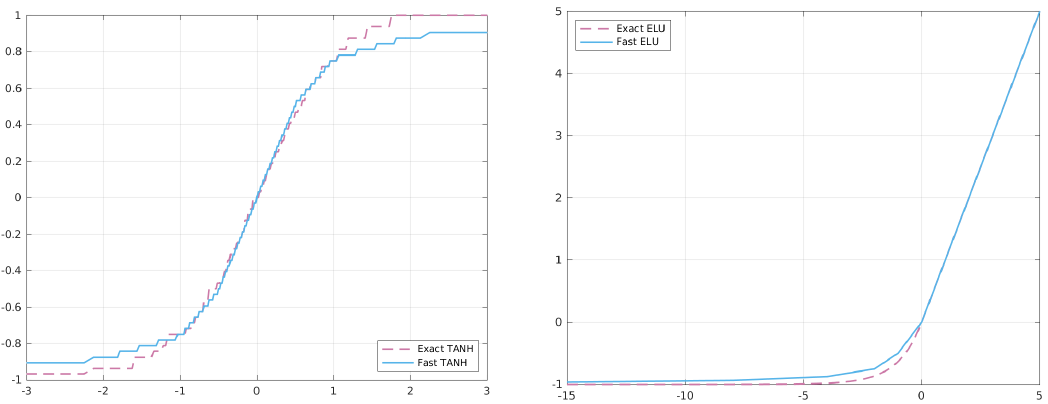
Figure 8. Comparison between the exact and approximated versions of hyperbolic tangent (TANH) and extended linear unit (ELU).